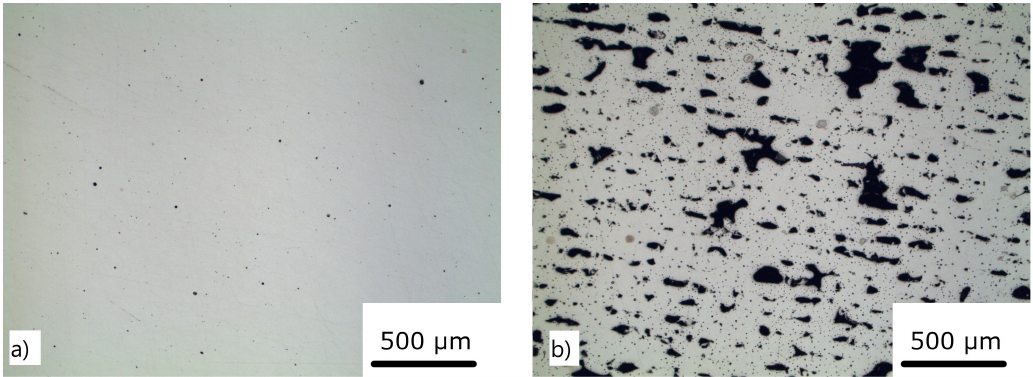
Figure 3. The optical image of the printed samples: ( a ) sample with energy density 144.13 J/mm 3 with porosity 0.064%; ( b ) sample with energy density 48.23 J/mm 3 with porosity 15.60%.